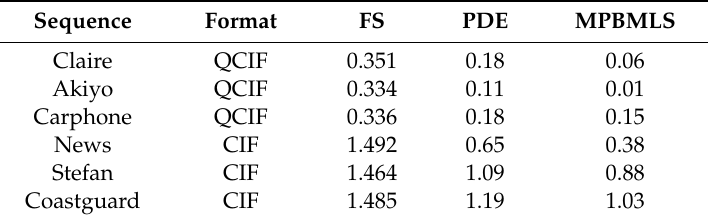
Table 2. Computation time (in second) required to handle 50 frames.